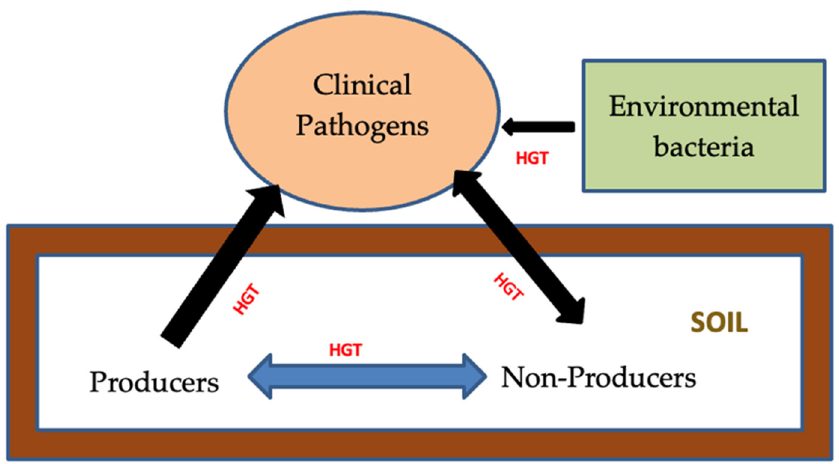
Figure 1. Pathways in which antibiotic resistance genes transfer from the natural environment to the clinical environment (inspired from